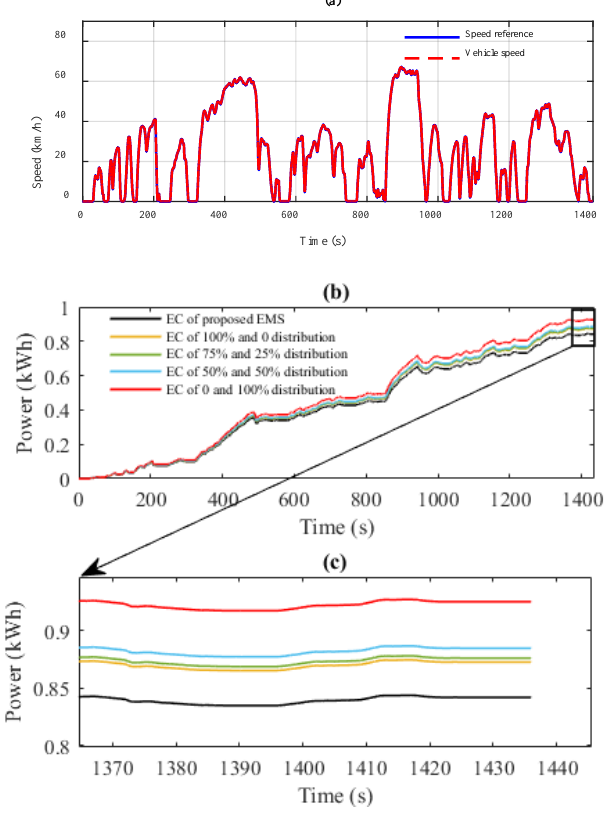
Figure 7. Energy consumption comparisons.